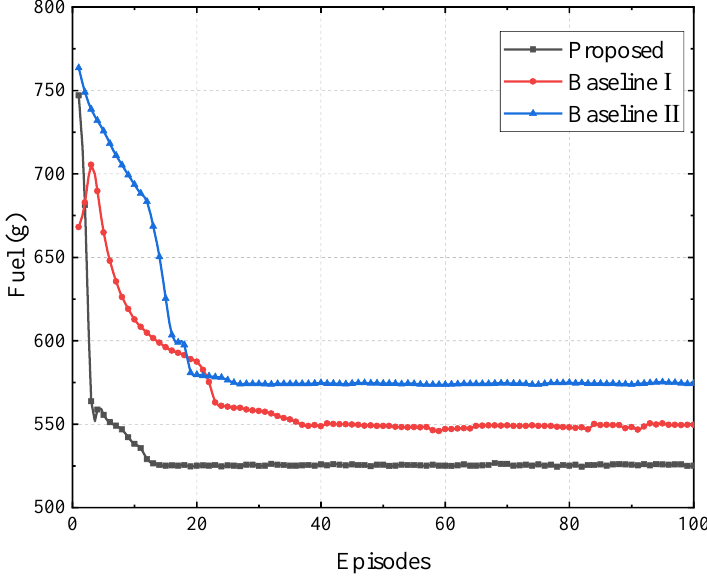
Figure 6. Fuel consumption trajectories in the training process. Table 4. Comparative Features of Different Strategies.